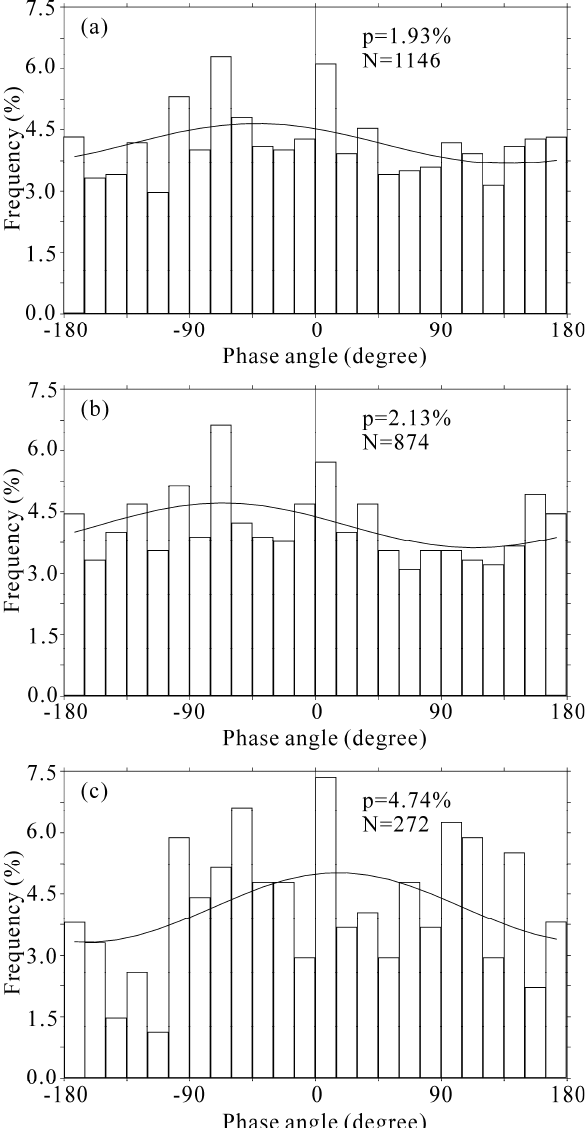
Figure 3. Frequency distributions of the tidal phase angles for the three subsets with any depth and different cutoff magnitudes: ( a ) any M; ( b ) 0 < M < 5; ( c ) M ≥ 5. The solid curves in ( a – c ) are sinusoidal functions fitting the distributions.